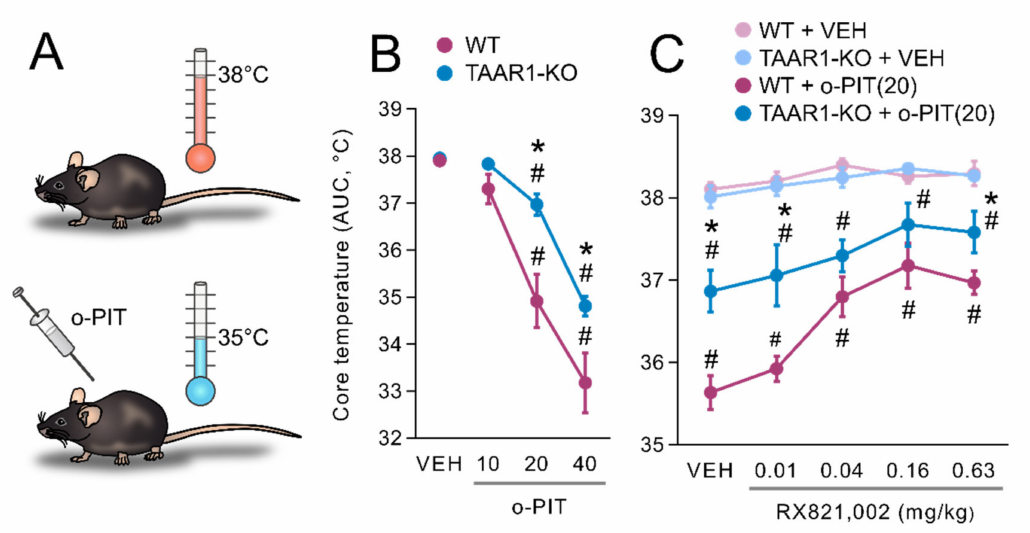
Figure 2. Drug interaction with o-PIT upon core temperature in TAAR1-KO and WT mice. ( A ) Schematic depiction of hypothermic effects of o-PIT. ( B ) Core temperature is expressed as area under the curve (AUC) calculated over the 120 min following administration of o-PIT (2.5–40 mg/kg). ( C ) Antagonists (mg/kg, s.c.) were administered 30 min prior to o-PIT (20 mg/kg). Core temperature was determined 60 min following o-PIT. ( C ) Dose-dependent (0.01–0.63 mg/kg) effect of RX821, 002 upon the effect of o-PIT. All data are means ± SEM. N = 6–8 per group. p < 0.05, influence of treatment (#) or genotype (*). VEH: vehicle.